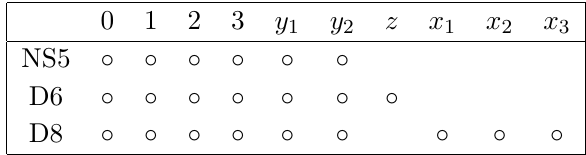
Table 1 . Localized D6-D8-NS5 brane